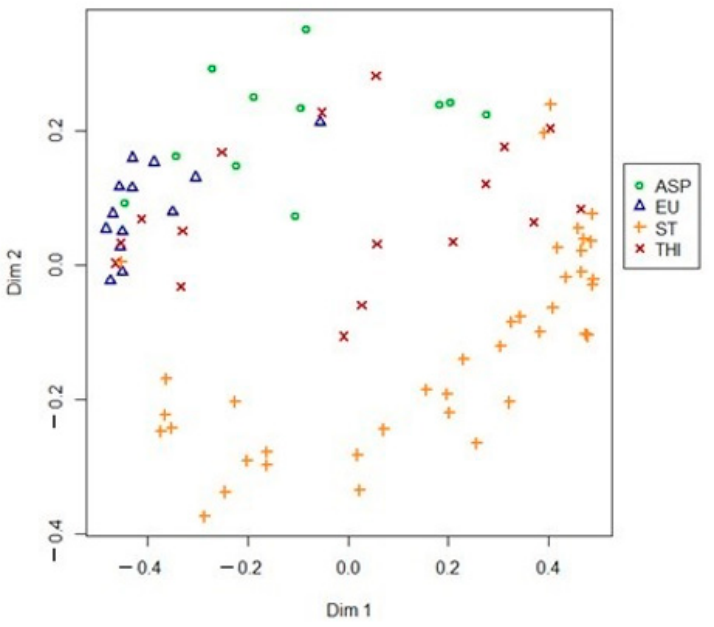
Figure 3. 2D visualization of unsupervised random forest.